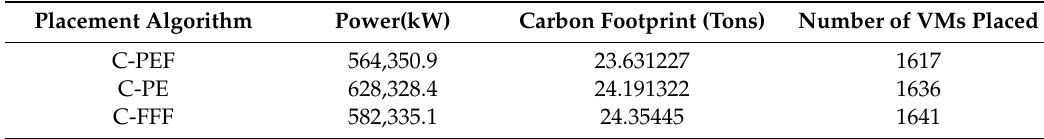
Table 10. Power and carbon footprint with dynamic power usage e ff ectiveness (PUE).